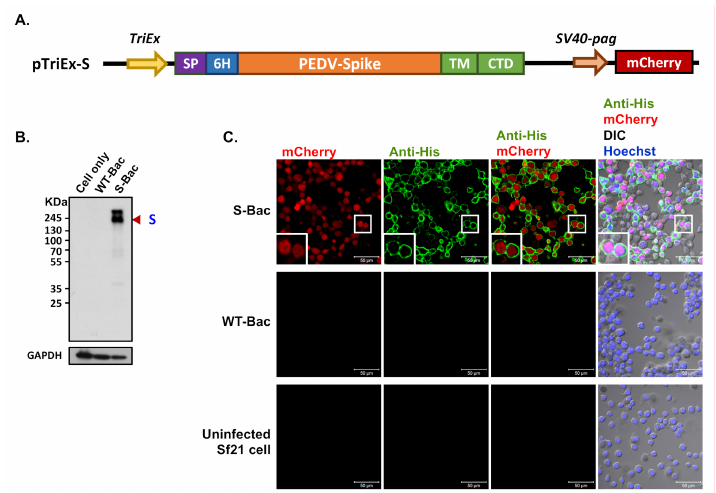
Figure 2. Determination of recombinant PEDV S protein expression by Western blot and IFA. ( A ) The construction map of the pTriEx-S plasmid. The full-length S gene of PEDV was cloned into pTriEx-4 plasmid to form pTriEx-S. The TM and CTD regions of the S protein were replaced with those of GP64 protein from baculovirus for proper membrane protein display. Expression of the S construct was driven by the TriEx promoter ( TriEx ), which was followed by the honeybee melittin signal peptide (SP) and 6X His tag (6H). An mCherry reporter driven by the SV40-pag promoter ( SV40-pag ) was also incorporated into pTriEx-S. ( B ) Western blot analysis of the recombinant S protein. S protein was expressed upon infection of S-Bac in insect cells and subjected to Western blot analysis.